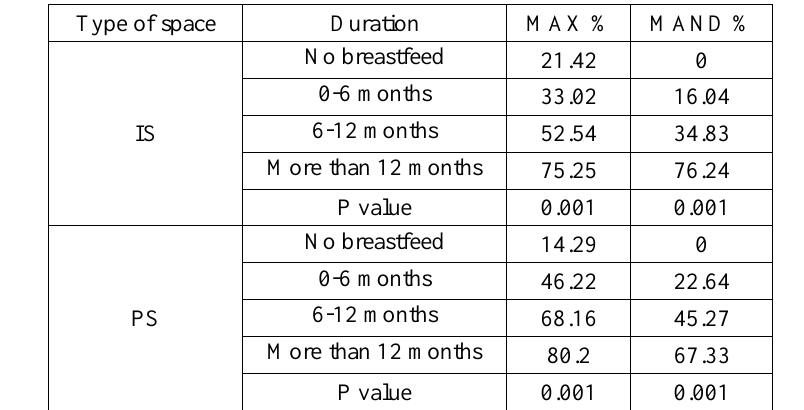
Table 2: the relation between the duration of breast feeding and the presence of IS and PS in both maxillary and mandibular arches